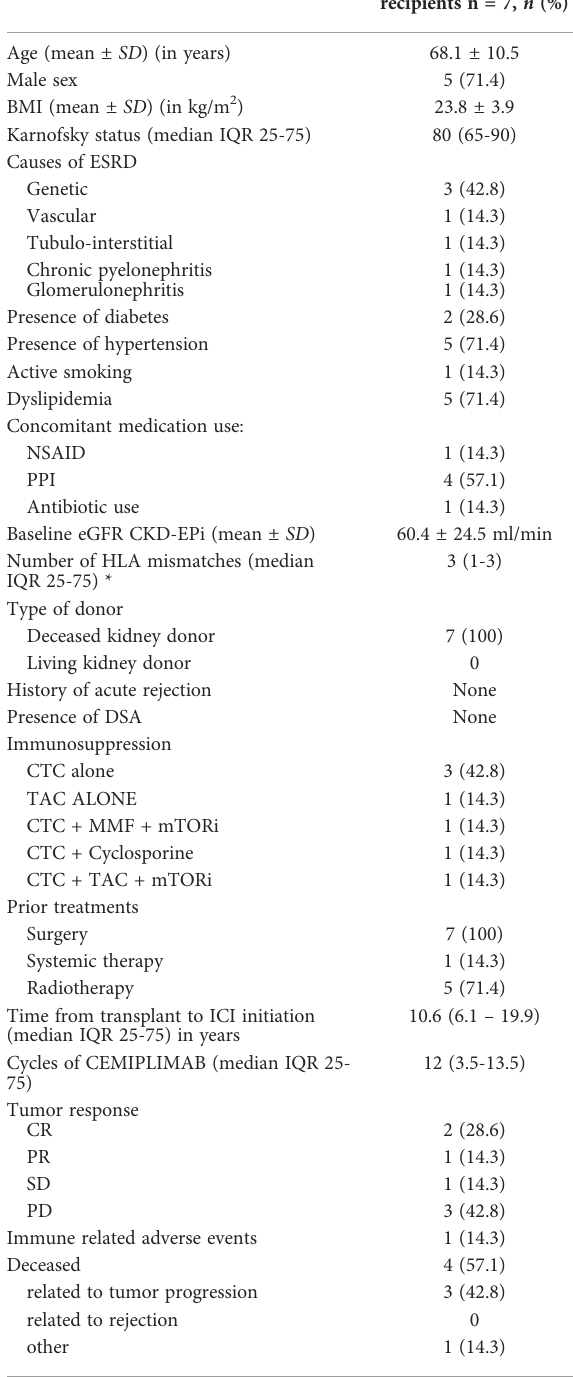
TABLE 1 Patients ’ characteristics and main